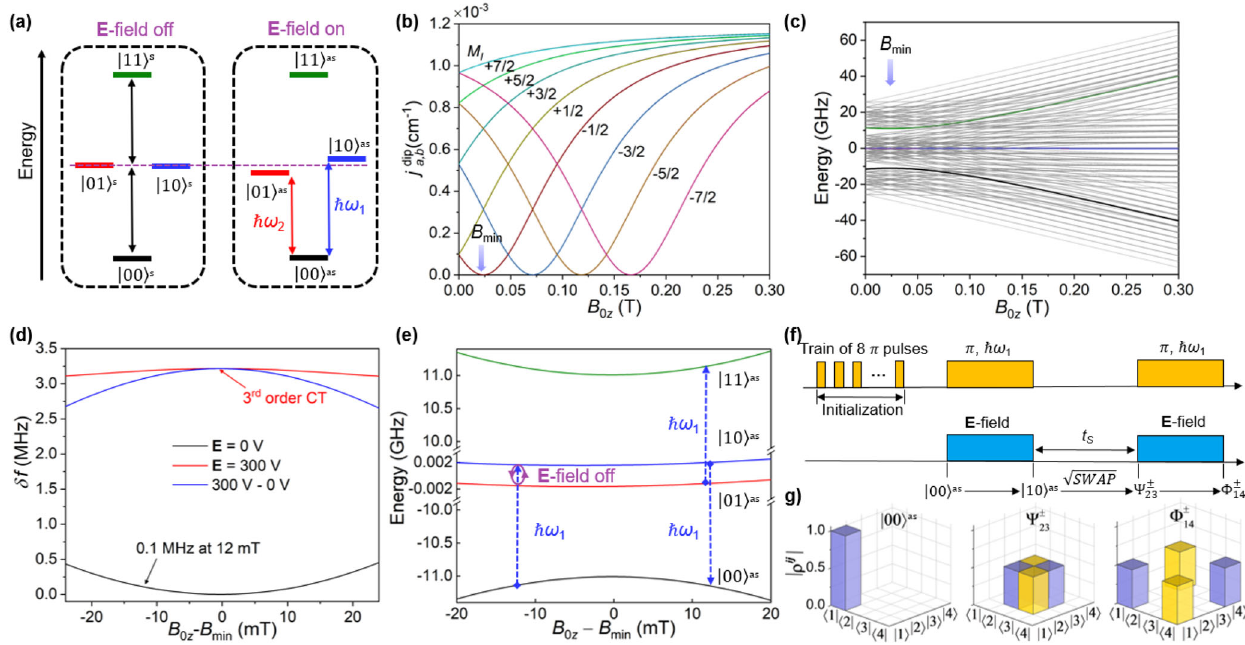
Fig. 3 Two-qubit entanglement generation. a Scheme of the qubit states in absence and presence of an E - fi eld. b Calculated dipolar ) of the 16 spin levels of a HoW 10 molecule interacting with its neighboring molecule. The M J = ± 4 levels with the same M I are exchange ( j dip a ; b overlapped. c Energy levels of the coupled HoW 10 dimer in the presence of an E - fi eld (300 V) with 2 mm interelectrode distance. The four operating levels are highlighted. The two middle levels (red and blue) are close to each other. d δ f as a function of B - fi eld with (red) and without (black) applied E - fi eld. The SEC effect is indicated by their difference (blue). e The operating space around the fi rst CT and the and Φ ± at 12 mT. f Pulse sequence and g related initial and Bell generation of the entangled states Ψ ± 14 23